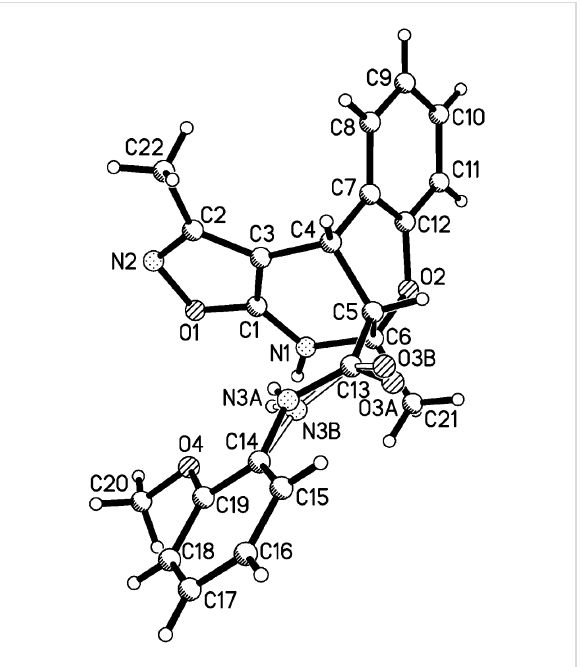
Figure 5: Molecular structure of compound 6a according to X-ray diffraction data.